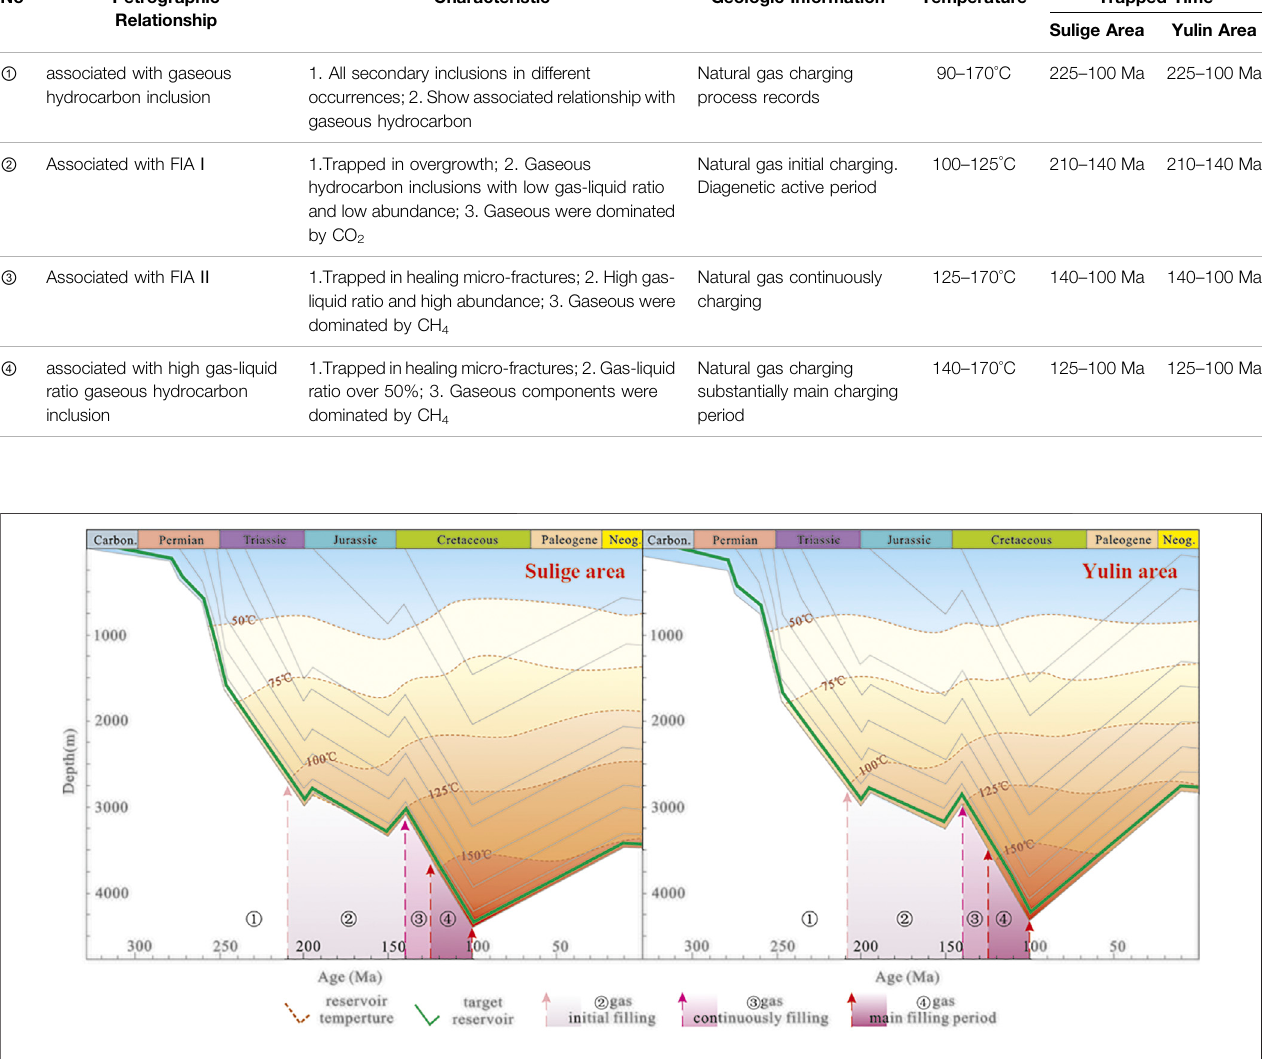
Frontiers in Physics |